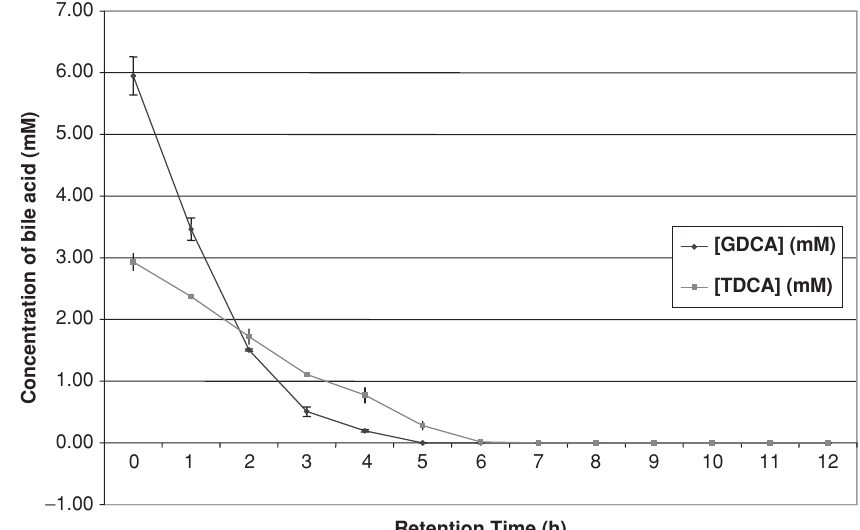
Figure 4 BSH activity and GDCA and TDCA depletion efficiency of immobilized Lactobacillus plantarum 80 (pCBH1) in in-vitro experiment. The concentration of GDCA and TDCA bile acids is shown over time. The experiment was performed in triplicate: error bars indicate standard